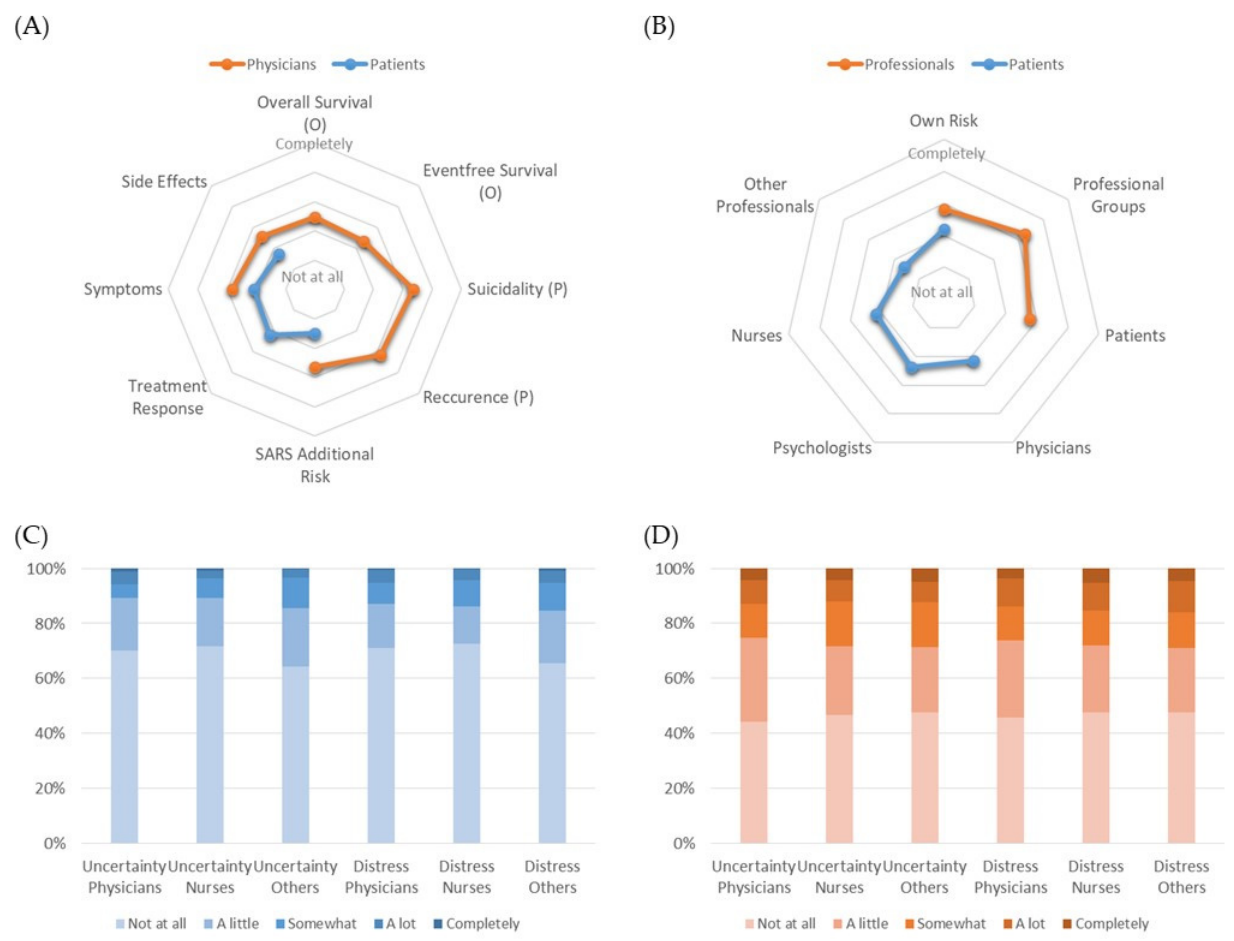
Figure 4. ( A ) Different perceptions of pandemic effects on criteria for treatment decisions between physicians and patients; ( B ) Perception of different aspects of burden of the opposite stakeholder group by patients and healthcare professionals; Recognition of decisional uncertainty and distress for healthcare professionals by patients in ( C ) oncology and ( D ) psychiatry. Chi 2 test showed significantly higher perception of burden in psychiatry compared to oncology in all six categories ( p < 0.001).